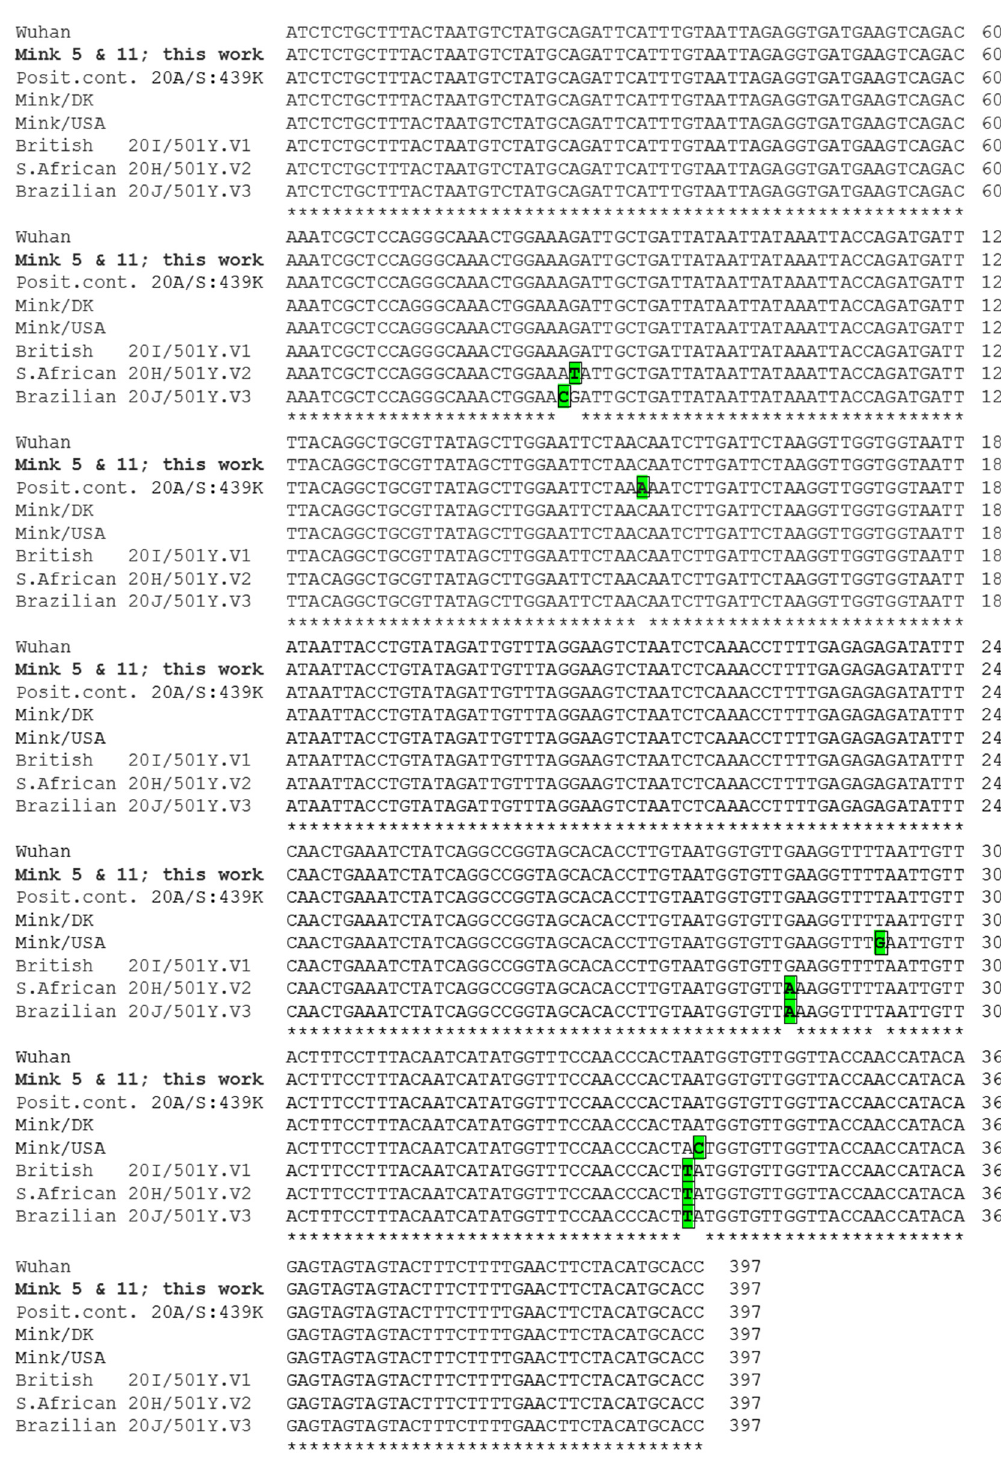
Figure 2. Alignment of partial S gene sequences. Sequences included, from top to bottom: Reference variant detected in Wuhan (GenBank ID: NC_045512.2); the presently identified sequence in mink 5 and 11 (in bold; both sequences are identical; GenBank and GISAID IDs MW741755 and EPI_ISL_1490748, respectively); positive control used (GISAID ID: EPI_ISL_423656); Danish mink sequence (GenBank ID: MT919536); USA mink sequence (GenBank ID: MW562304); and the variants indicated with their trivial and canonic designations (British, GISAID ID: EPI_ISL_581117; South African, GISAID ID: EPI_ISL_660605; Brazilian, GISAID ID: EPI_ISL_792680). Identical regions are marked at the bottom by asterisks. Base deviations from the Wuhan sequence are green shadowed and squared.